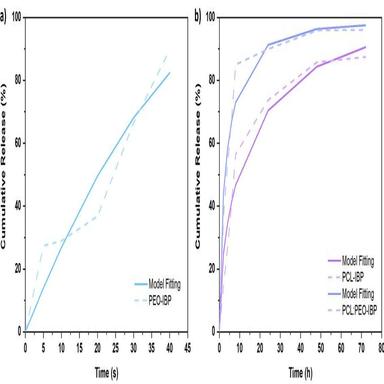
a) Fit of simple dissolution model (dashed) for the PEO fibers loaded with IBP (solid) for the data and b) Fit of a diffusive release model (dashed) for PCL and PCL:PEO fibers loaded with IBP (solid) for the data.